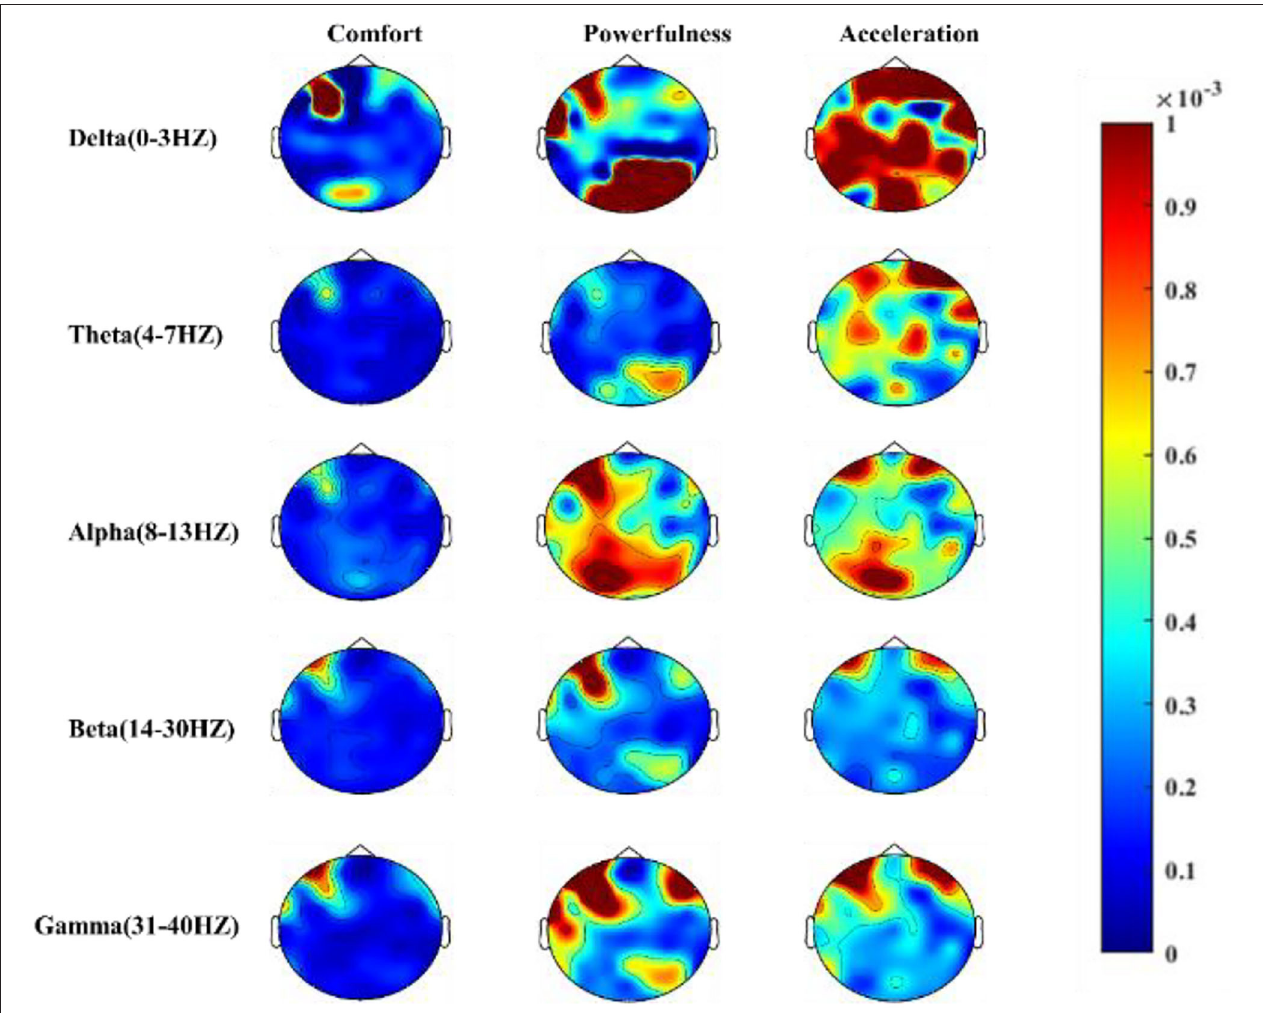
FIGURE 6 | Power topographic maps for the three types of car sounds in five rhythms.